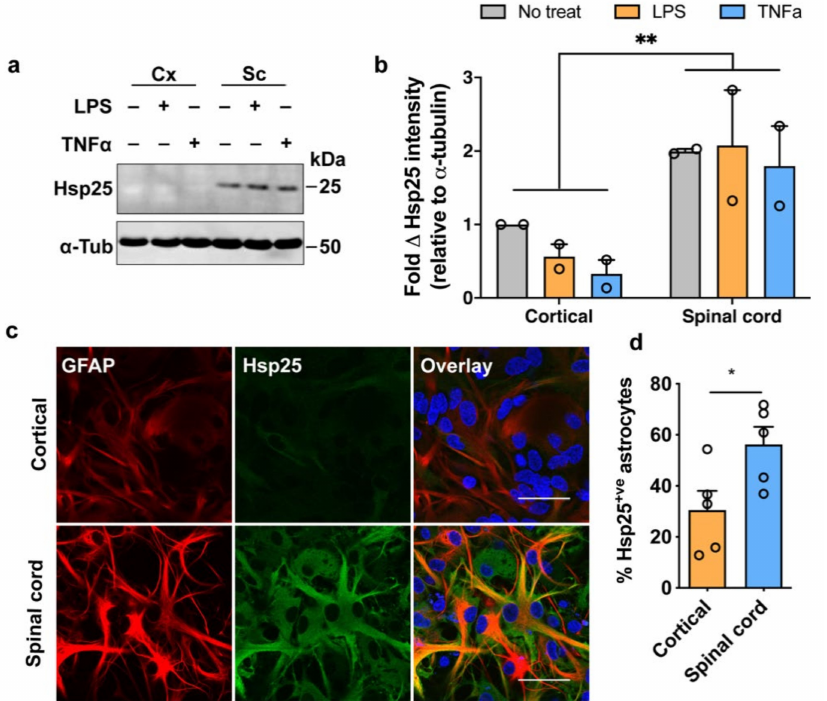
Figure 1. Hsp25 expression in LPS- or TNF α -stimulated primary cortical and spinal cord glial cultures. ( a ) Mixed primary cortical (Cx) and spinal cord (Sc) glia were treated with 80 µ g/mL LPS or 100 ng/mL TNF α for 24 h. 30 µ g of total protein was immunoblotted and probed for Hsp25 (25kDa) and α -tubulin (50 kDa). ( b ) Fold change in Hsp25 band intensity relative to the untreated cortical sample and normalised to α -tubulin to account for differences in protein loading. Data presented are the mean ± SEM from three biological replicates. Statistically significant differences between the means were assessed using a two-way ANOVA followed by Bonferroni’s post hoc test. ( c ) Representative images of untreated cortical and spinal cord glial cultures immunolabelled for GFAP (astrocytic marker; left) and Hsp25 (middle). Overlay (right) is shown with DAPI nuclear stain. Scale bar = 30 µ m. ( d ) The proportion of Hsp25 +ve astrocytes from cell counts of cortical and spinal cord glial cultures. Data shown are from one biological replicate and are the mean ± SEM of >300 cells across five wide field of view images. Statistically significant differences between the means were assessed using Student’s t -test, where p < 0.05 (*), p < 0.01